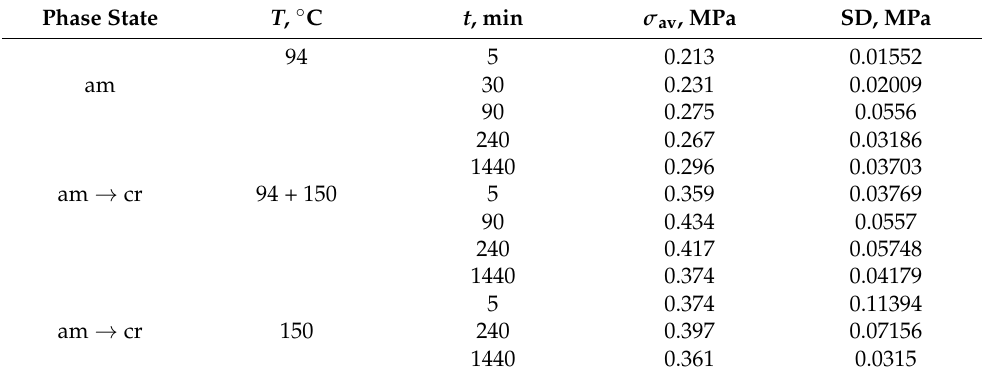
Table 2. NP or Q–Q plots of the statistical results ( σ av and SD) estimated for PET–PET interfaces. Phase